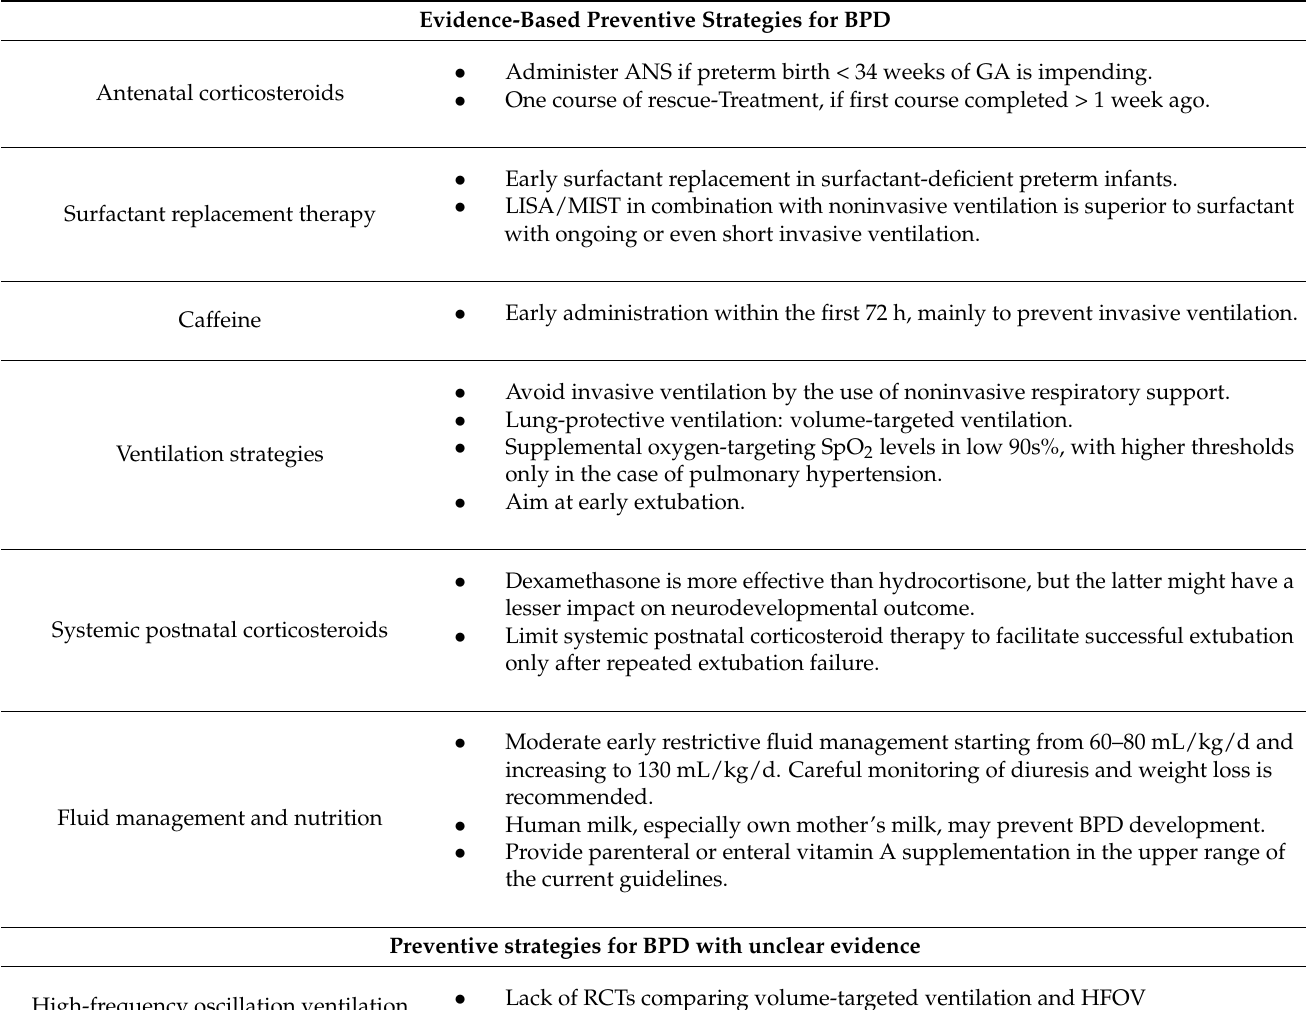
Table 2. Preventive strategies for